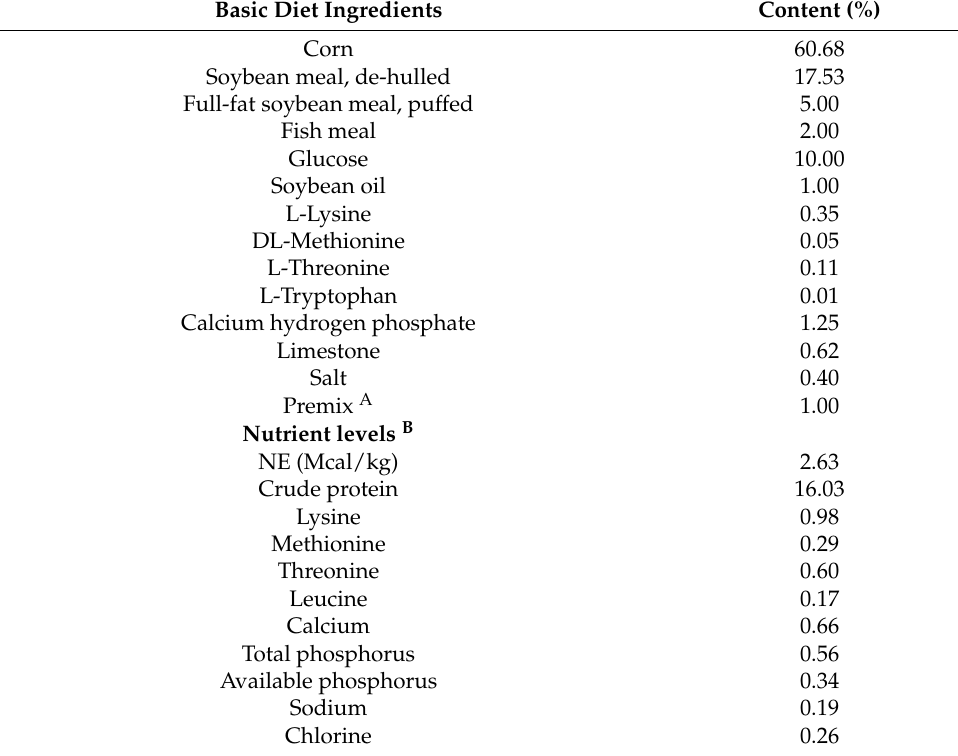
Table 2. Composition of glucose-supplemented